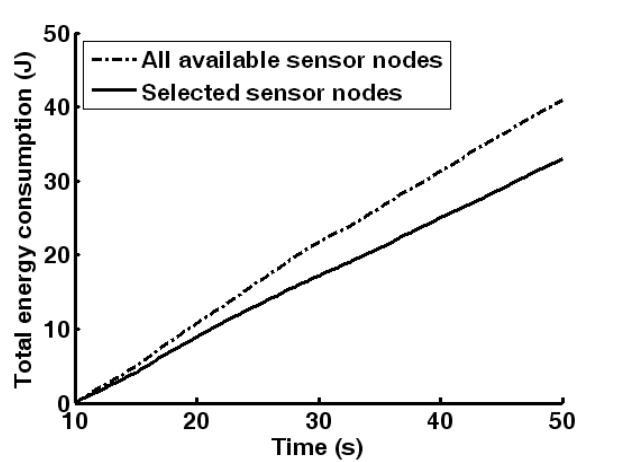
Figure 13. Total energy consumption in target tracking simulation with